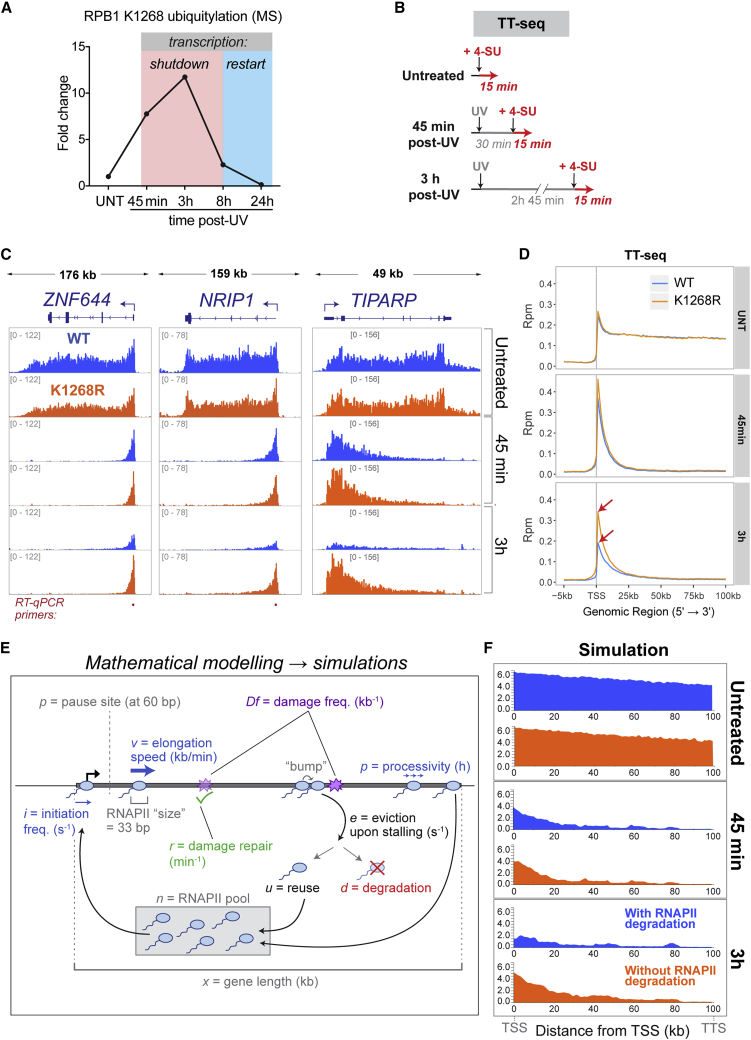
RPB1 Degradation Is a Major Determinant of UV-Induced Shutdown of Transcription Initiation(A) Relative abundance of K1268 ubiquitylation, before and at different times after UV irradiation (20 J/m2), quantified by TMT Gly-Gly IP mass spectrometry. Data are normalized to untreated controls. Different stages of the transcriptional UV-response are indicated by red and blue boxes.(B) Diagram of experimental design for TTchem-seq analysis.(C) Browser tracks from TTchem-seq experiment, at ZNF644, NRIP1, and TIPARP. The data are normalized to yeast spike-in. RT-qPCR primers used for validation are indicated below gene panels.(D) Metagene TTchem-seq profiles of genes ≧100 kb, in untreated cells and after UV irradiation (20 J/m2). Data are normalized to yeast spike-in. TSS, transcription start site.(E) Graphical representation of variables used for in silico simulation of RNAPII activity.(F) Simulated RNAPII activity on a 100-kb long gene, before and after DNA damage. RNAPII degradation upon stalling was either allowed (blue panels) or not (orange panels). For all parameter values used, refer to Table S3.See also Figure S3.